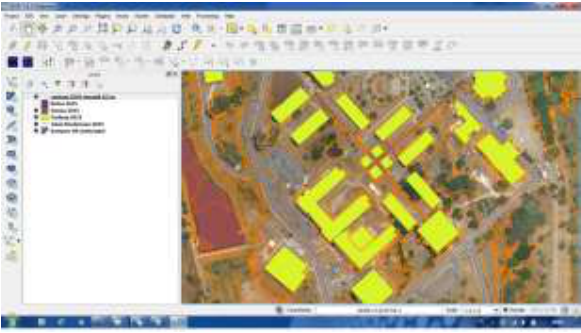
\Figure 10. Contour and 2D footprint